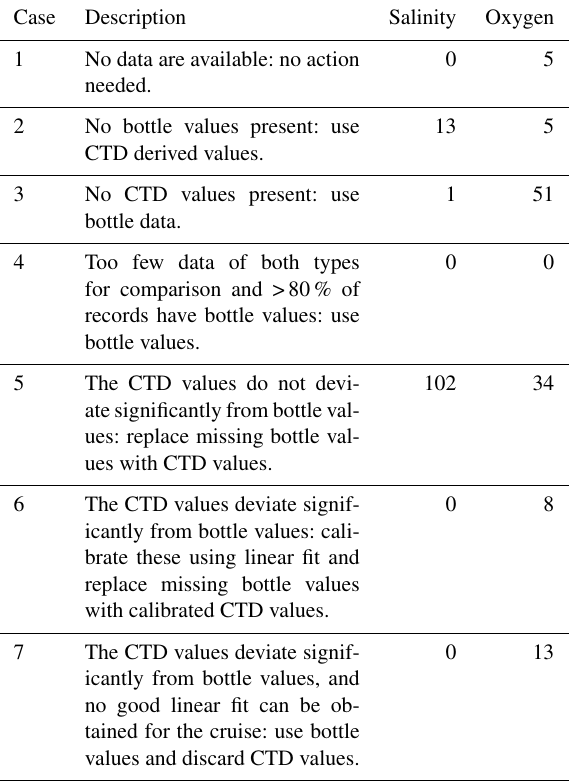
Table 4. Summary of salinity and oxygen calibration needs and ac- tions; number of occurrences for each of the scenarios